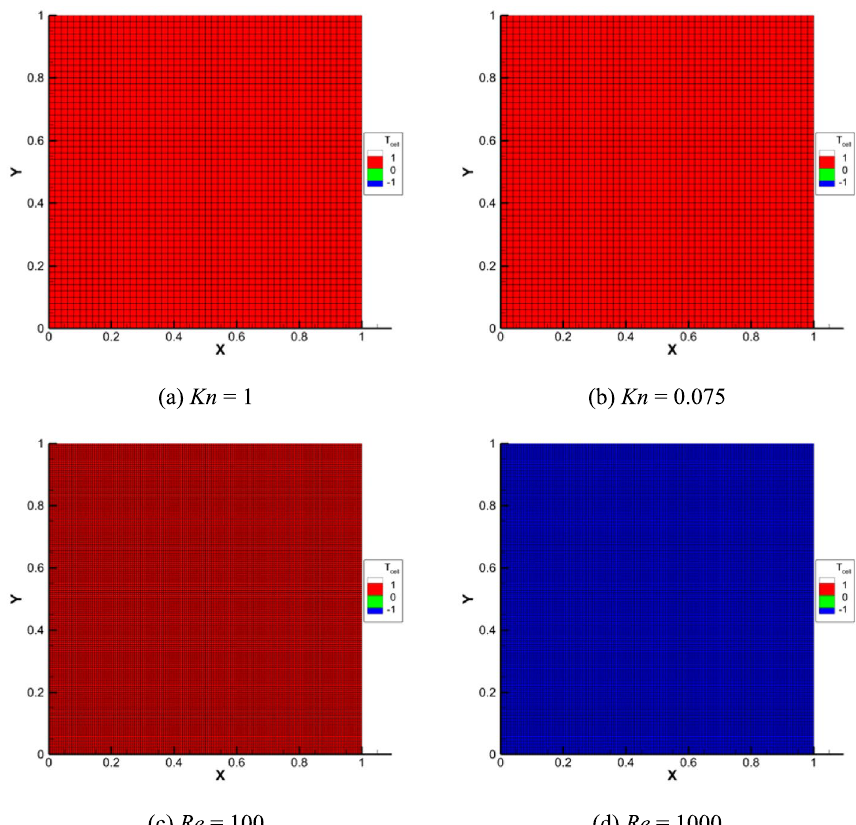
Fig. 5 Distribution of the DUGKS cell and the N-S cell for lid-driven cavity flow with different Knudsen/ Reynolds